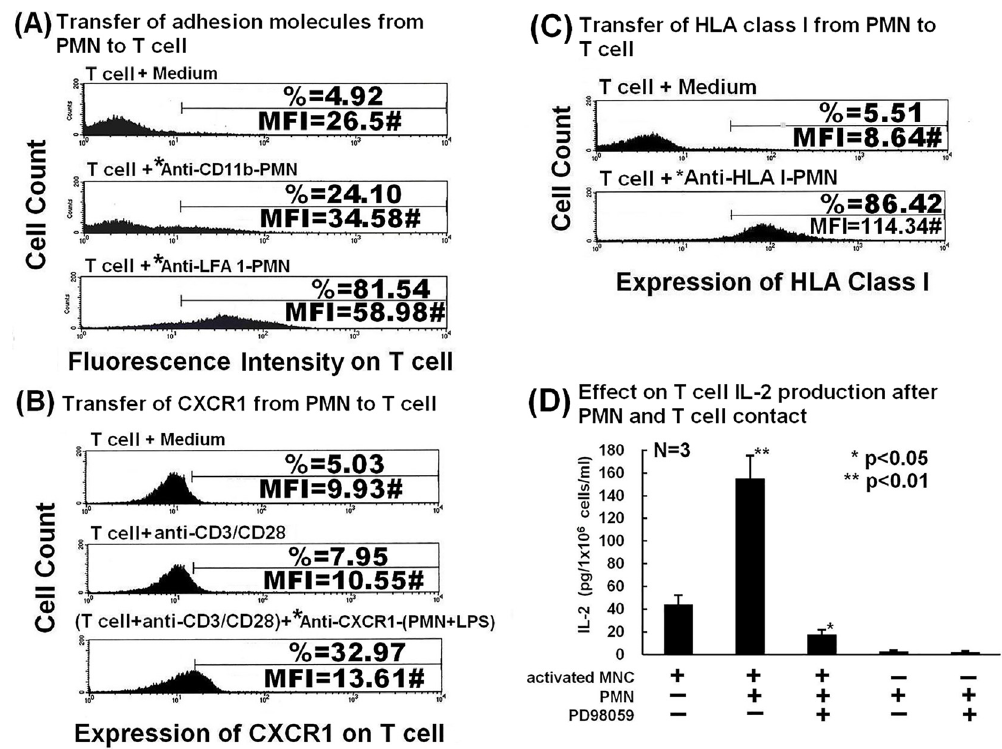
Fig 6. Detection of transfer of specific surface-expressed molecules from PMN to T cells and effects on IL-2 production by anti-CD3/anti-CD28 activated MNCs. Results of FACS analysis demonstrating (A) transfer of adhesion molecules CD11b and LFA-1, (B) transfer of CXCR1, and (C) transfer of HLA class-I from PMN to T cells after co-culture for 2 h. * FITC-antibody-stained PMNs. (D) Effects of autologous PMNs and MAP kinase inhibitor PD98059 on IL-2 production by activated human